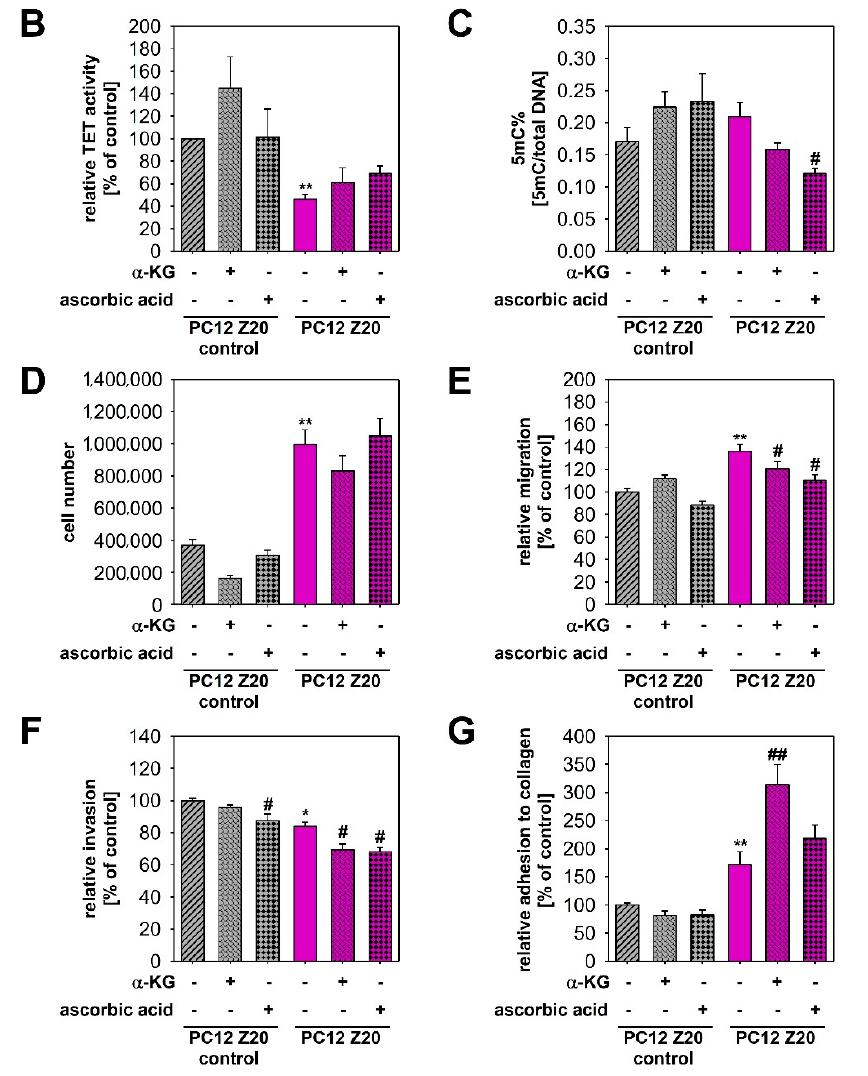
Figure 5. Epigenetic changes in PC12 Z20 cells and their phenotypic consequences. ( A ) DNA methylation is exerted by DNA methyltransferases (DNMTs), which transfer methyl groups from S-adenosylmethionine to cytosine (C) forming 5-methylcystosine (5mC). Demethylation is initiated by α -ketoglutarate ( α -KG)-dependent ten eleven translocation (TET) dioxygenases that catalyze the oxidation of the methyl groups thereby converting 5mC to 5-hydroxymethylcytosine (5hmC), 5-formylcytosine (5fC), and 5-carboxycytosine (5caC). In addition to α -KG, ascorbic acid can also increase the activity of TETs. ( B ) PC12 Z20 cells showed a significant downregulation of TET enzyme activity compared with PC12 Z20 control cells. Treatment with either 10 µ M α -KG or 0.5 mM ascorbic acid resulted in a slight upregulation of the TET activity in PC12 Z20 cells. A total of three independent experiments ( n = 5). ( C ) Global DNA methylation assays revealed in trend an upregulation of 5mC in PC12 Z20 cells compared with control that could be diminished by treatment with ascorbic acid or α -KG. ( D ) Cell number after 240 h cultivation in absence or presence of either α -KG or ascorbic acid. A total of four independent experiments ( n = 8). Influence of α -KG and ascorbic acid on ( E ) migration, ( F ) invasion, and ( G ) adhesion capacity of PC12 Z20 and PC12 Z20 control cells. Between three and four independent experiments ( n = 16–18). Mean ± SEM; Anova and Bonferroni post hoc test comparison vs. PC12 Z20 control * p < 0.05, ** p < 0.001; vs. untreated respective sub-cell line # p < 0.05, ## p <